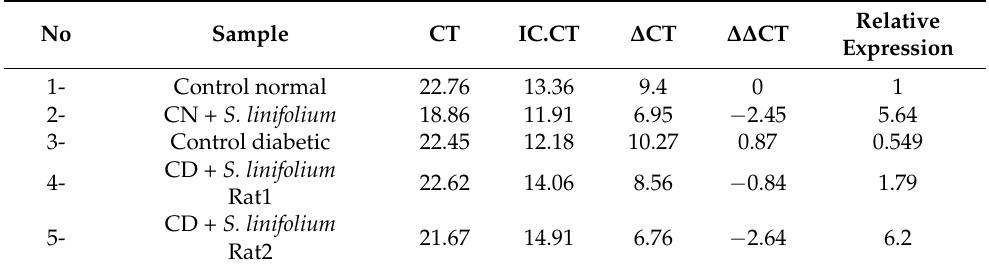
Table 8. Real-time PCR data analysis for AMPK expression of phlorotannins extracted from S. linifolium